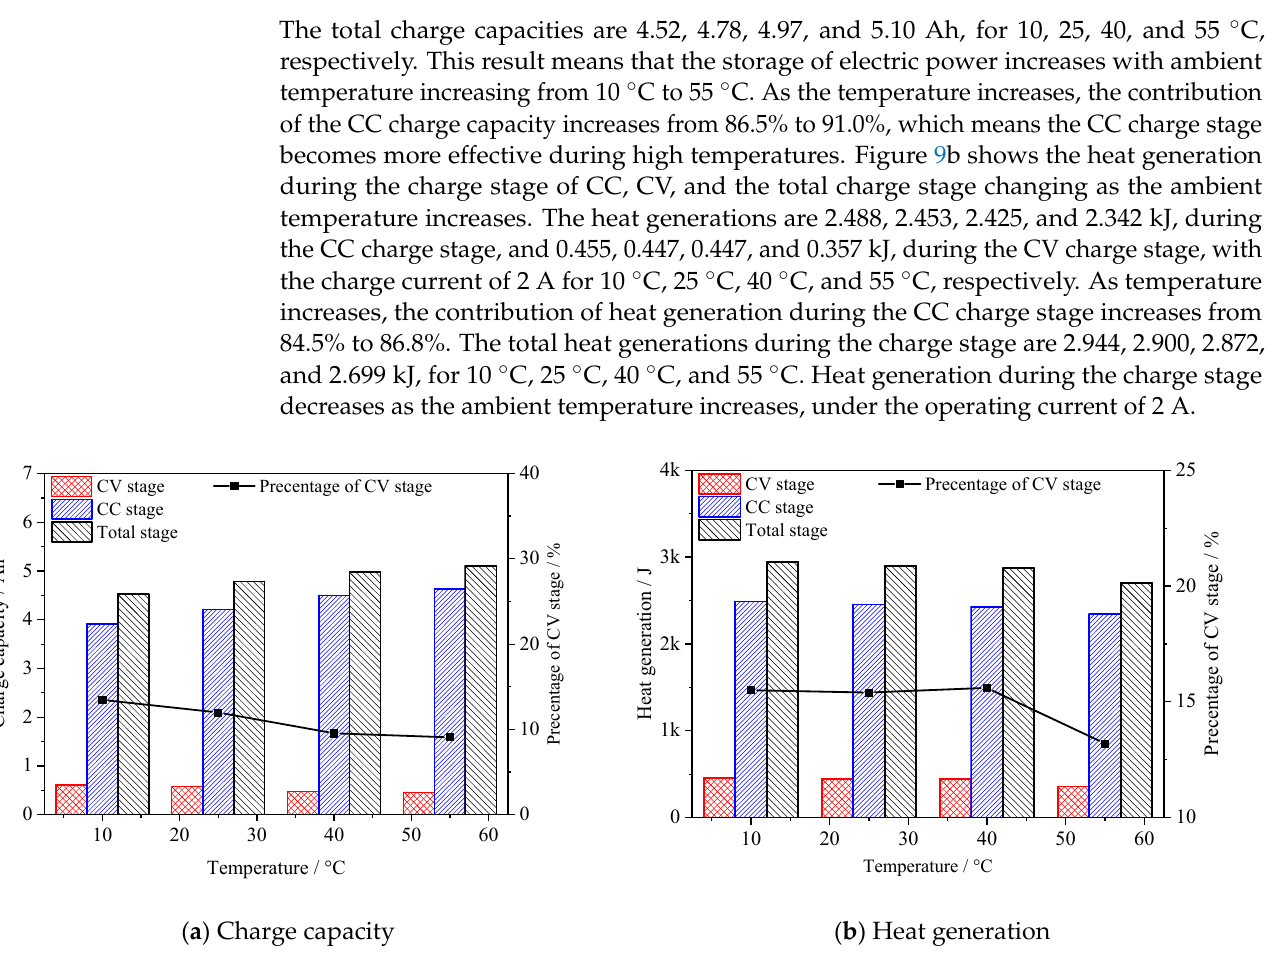
Figure 10. Effect of ambient temperature on the battery during the discharge stage.